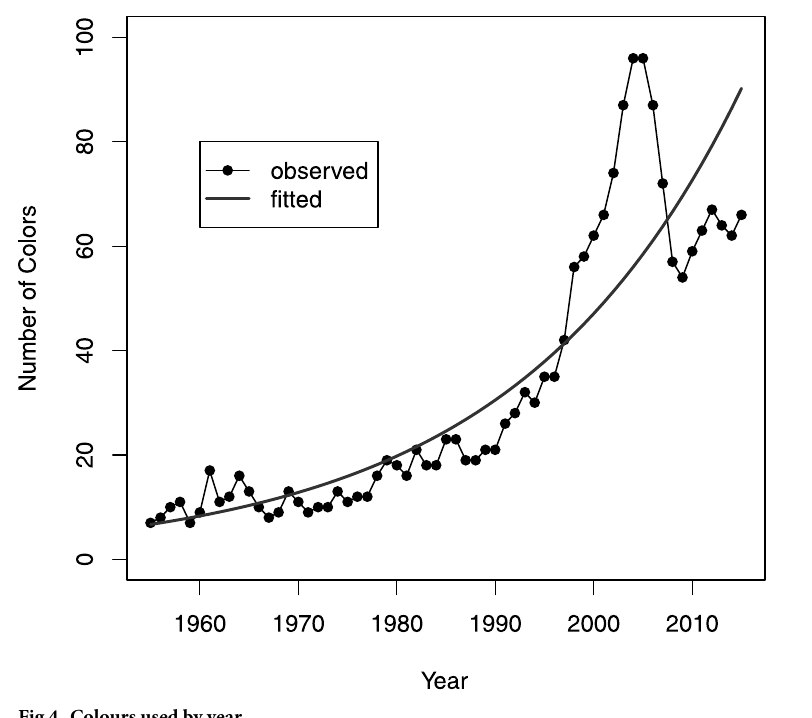
Fig 4. Colours used by